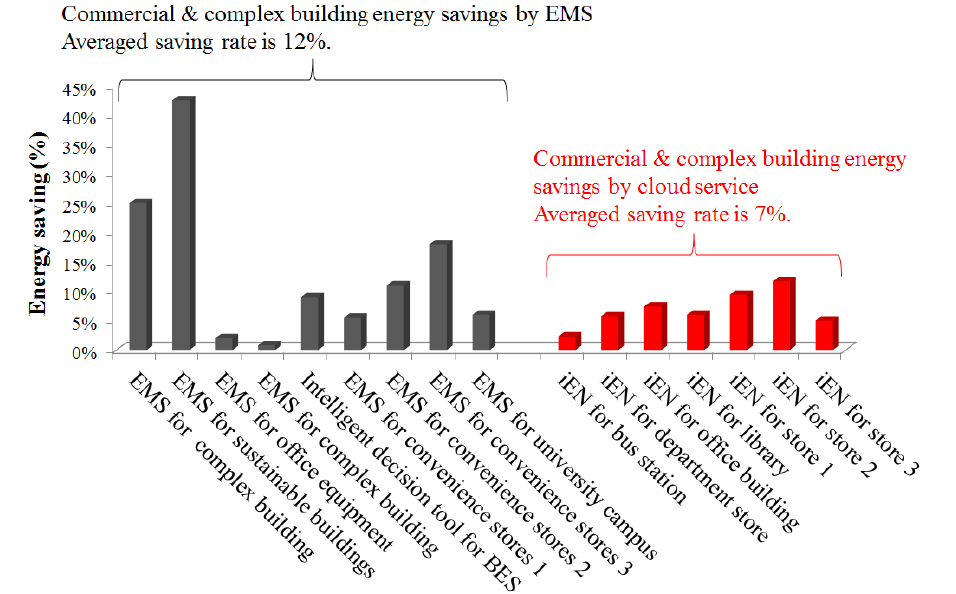
Figure 4. Comparison of energy savings of commercial and complex buildings by applying EMS and